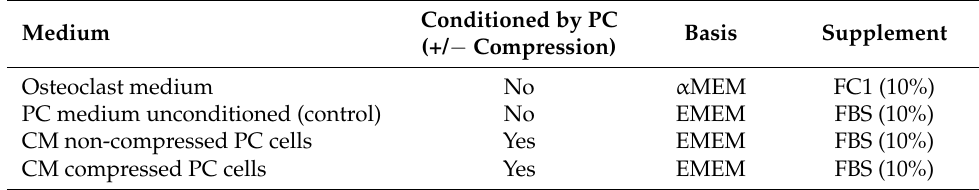
Table 2. Osteoclastogenesis media.